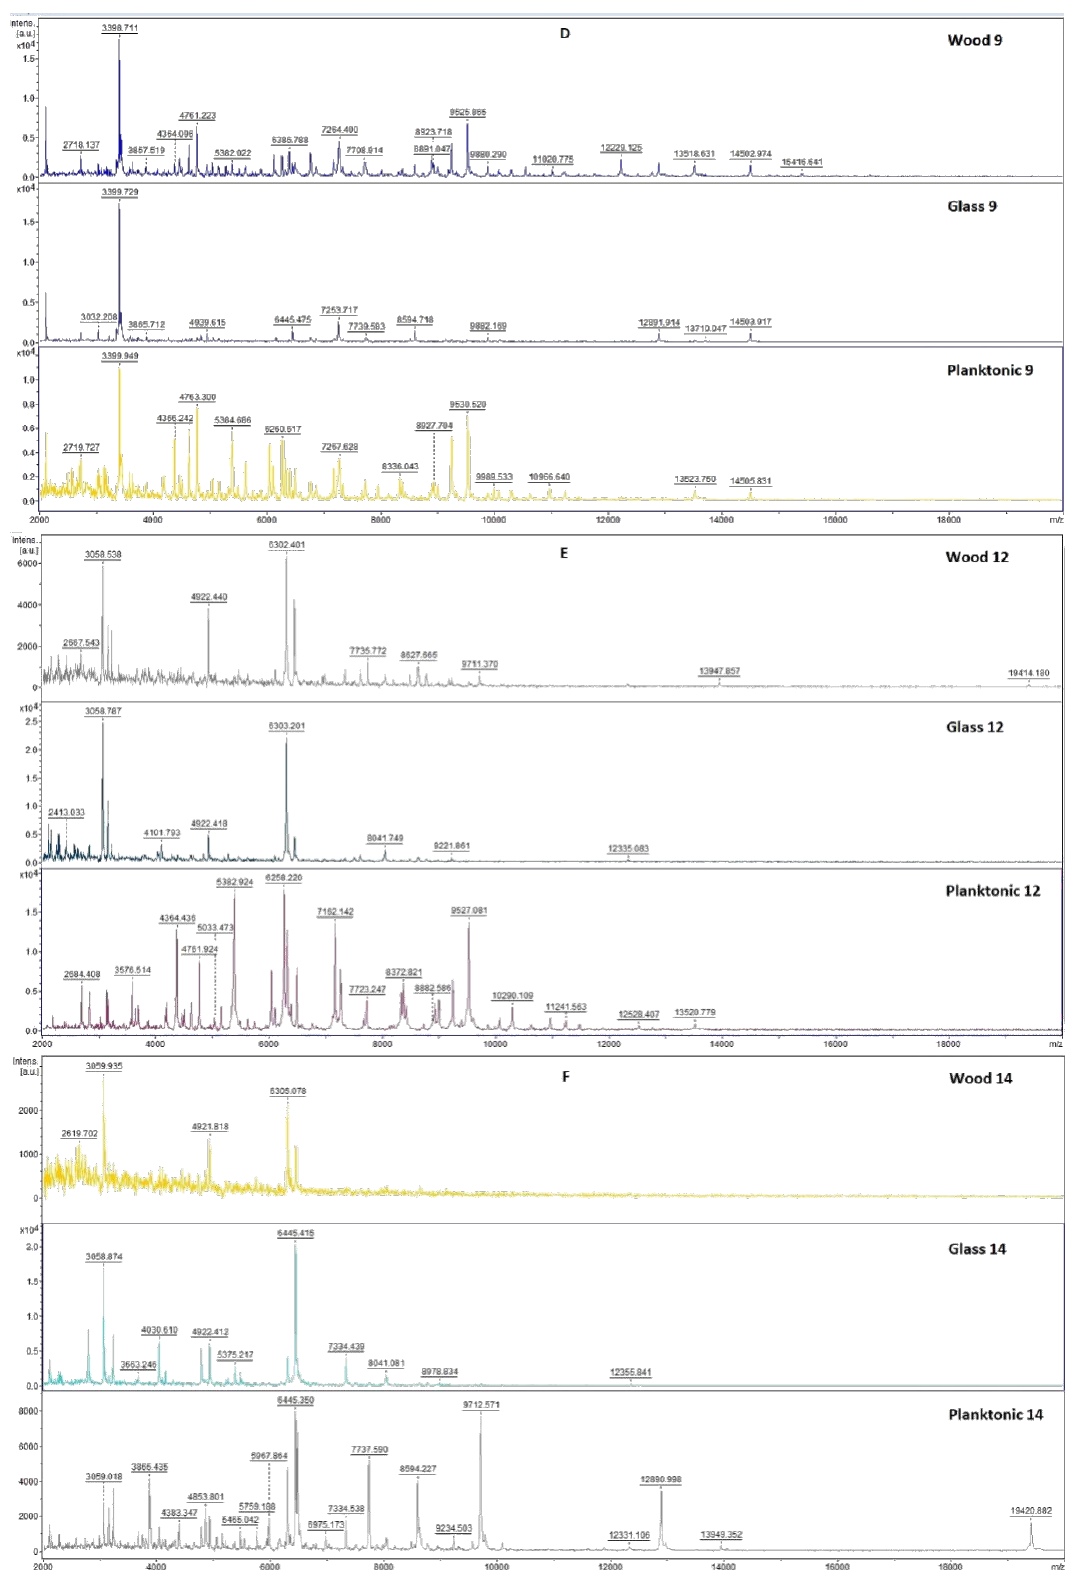
Figure 3. Representative MALDI-TOF mass spectra of P. fluorescens : ( A ) 3rd day, ( B ) 5th day, ( C ) 7th day, ( D ) 9th day, ( E ) 12th day, and ( F ) 14th day .